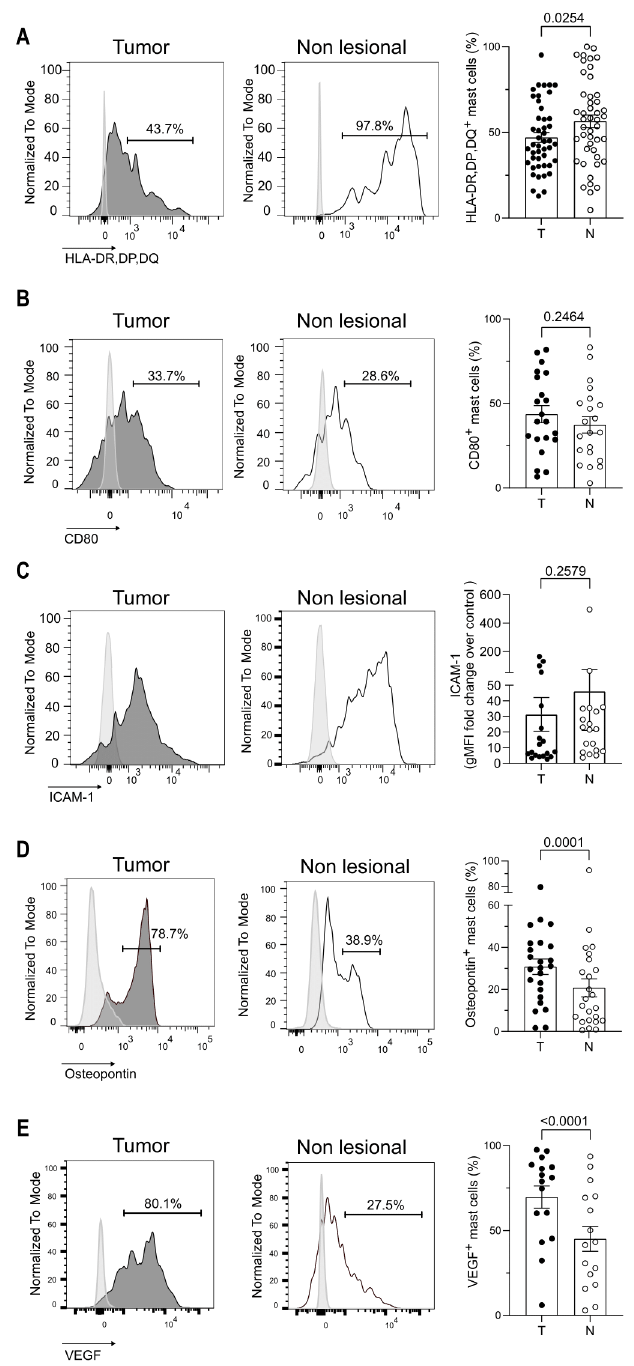
Figure 4. Key markers of MC-associated functions are altered in the TME. ( A – E ). Left panels: Representative histograms showing the expression of the indicated marker in MCs from tumoral and non-lesional-matched lung tissues analyzed by flow cytometry. Right panels: data are presented as cell frequency ( A , C – E ) or gMFI fold change over unstained control ( B ) for the indicated marker (mean and SEM). Each dot represents one patient. Wilcoxon signed-rank test.